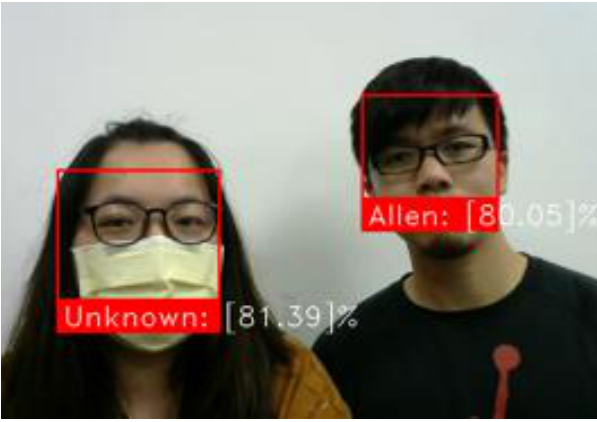
Figure 42. Human face detection in real time (YOLO).